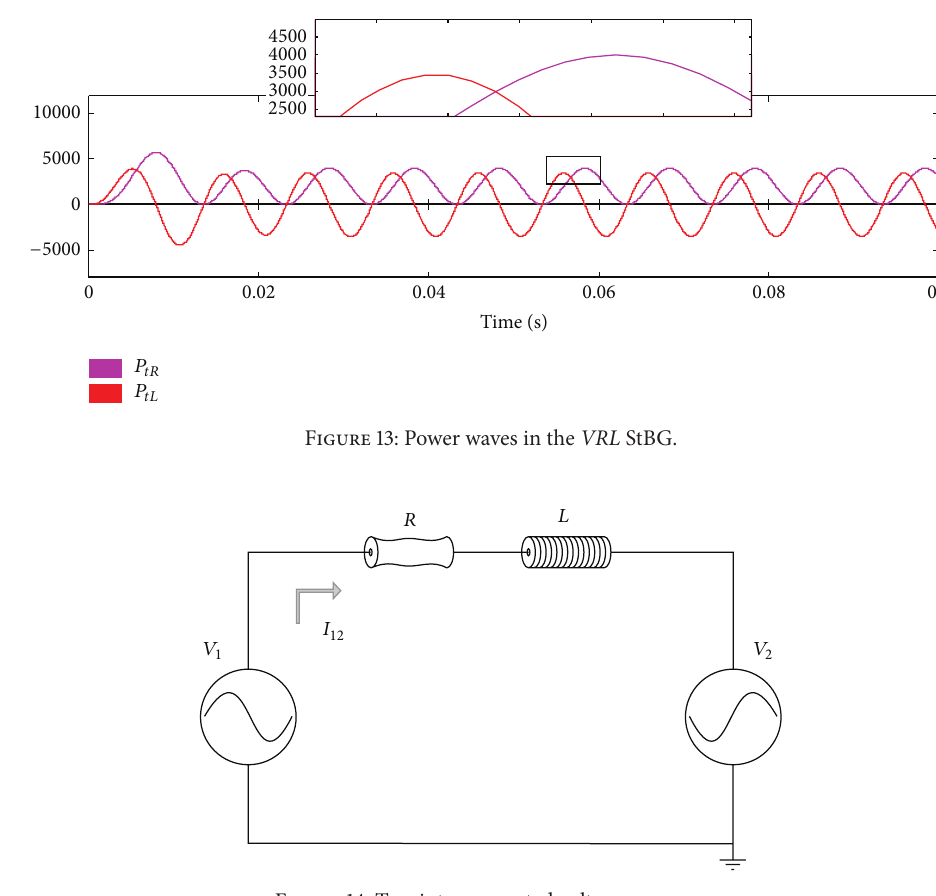
Figure 14: Two interconnected voltages